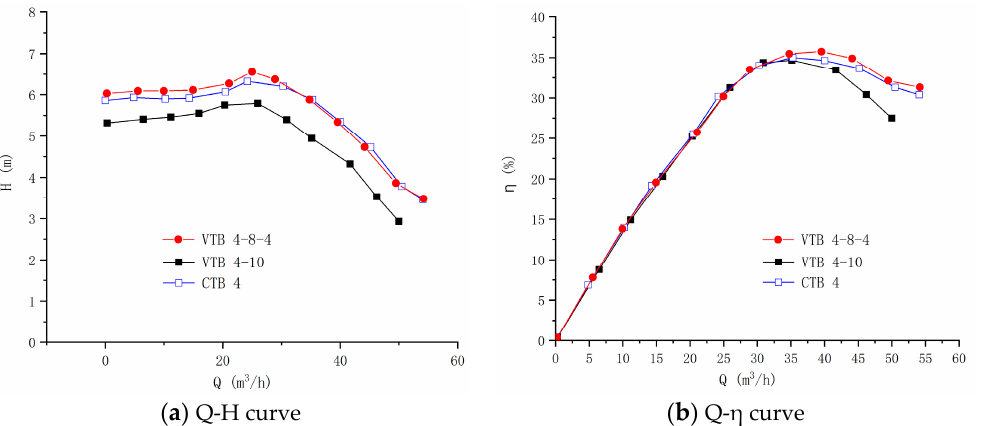
Figure 16. Test results of plastic centrifugal pump.